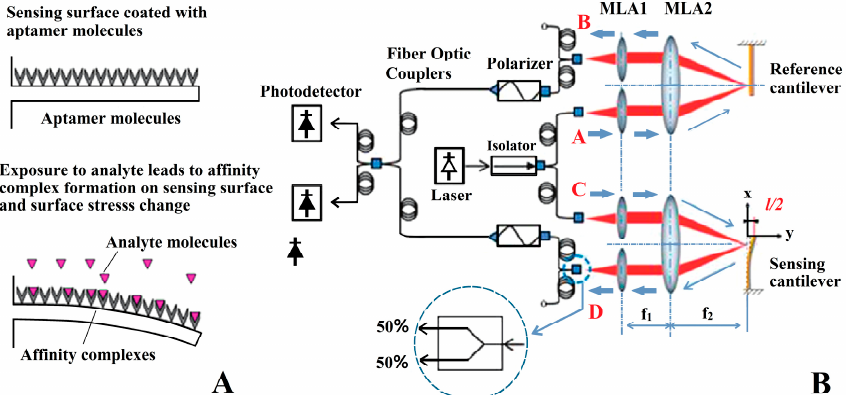
Figure 4. The aptamer-modified microcantilever sensor for cocaine detection. ( A ) Schematic rep- resentation of the sensing strategy for cocaine detection. ( B ) Optical circuit of differential surface stress sensor. Laser wavelength is 635 nm. A pair of microlens arrays with lenses of 240 and 900 μ m diameter, and pitches of 250 μ m and 1 mm, respectively, were used to direct the beams toward the sensing/reference pair [65].